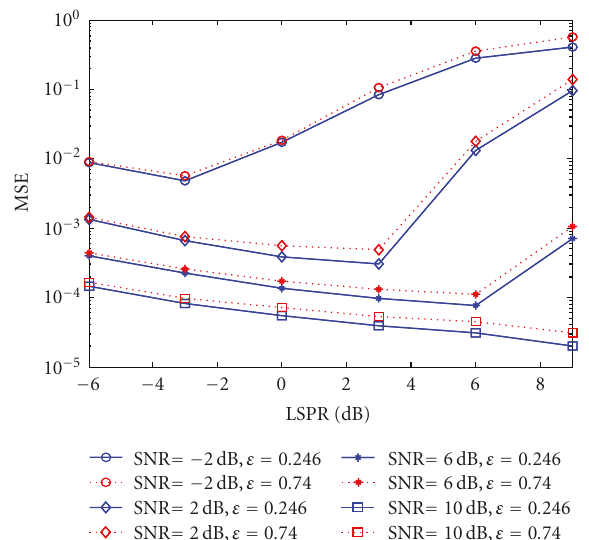
Figure 15: MSE performance of the proposed frequency o ff set estimation scheme according to LSPR